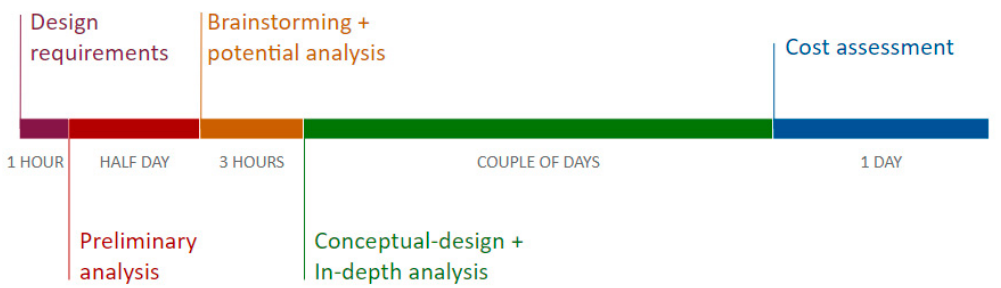
Figure 2. Example of timeline for a common design process involving additive technologies in the field of machined parts.